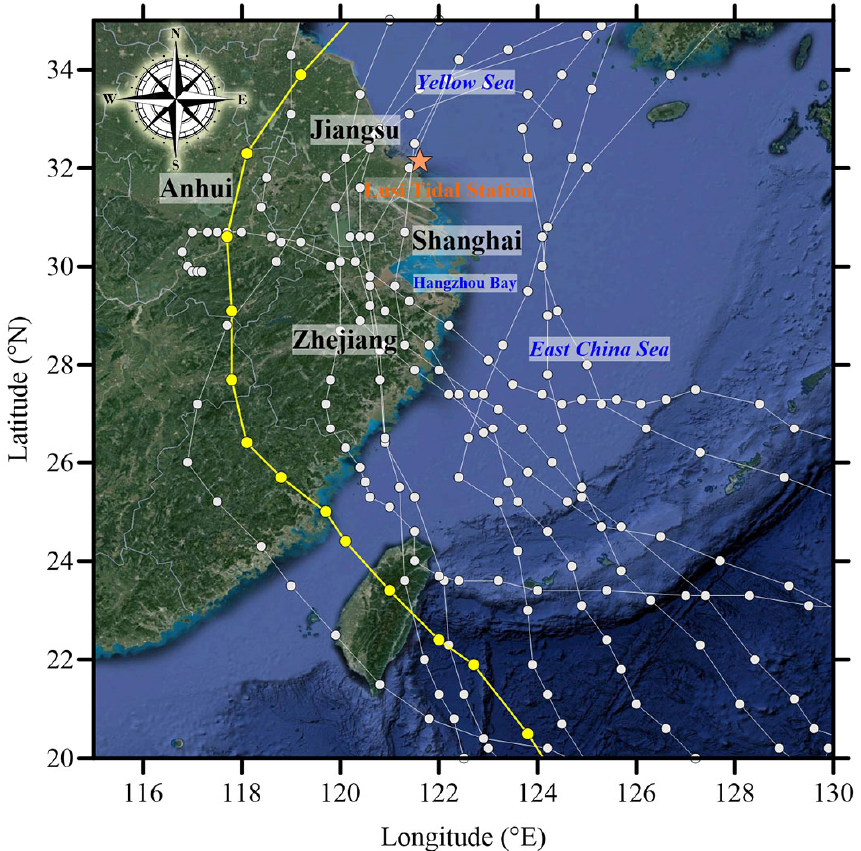
Figure 3. The East China Sea with the tracks of 12 typhoons from 1986 to 2016. The yellow line represents the track of Typhoon No. 1410 in 2014 and the white lines represent the tracks of the rest 11 typhoons. The time interval between contiguous dots is 6 hours. Table 1. Oceanic and meteorological sample data during Typhoon No. 1410.